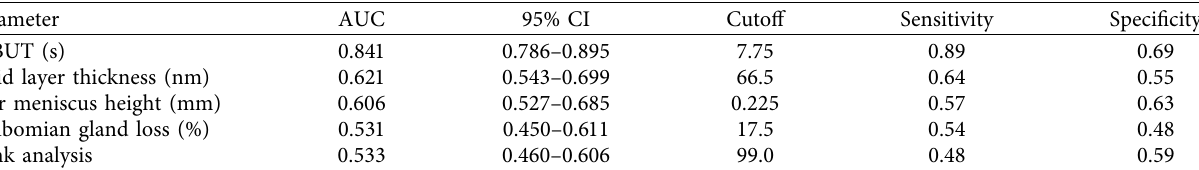
Table 2: Area under the curve (AUC) with 95% confidence intervals (CIs), optimal cutoff values, and corresponding sensitivity and specificity for the analyzed ocular surface parameters.